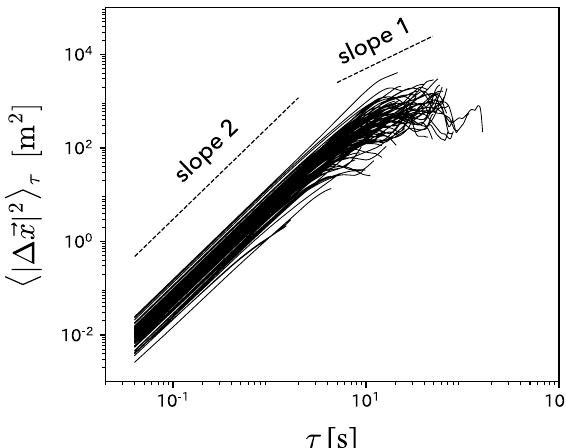
Figure 2. τ dependence of the mean squared displacement of soccer players. The graph is shown in double logarithmic